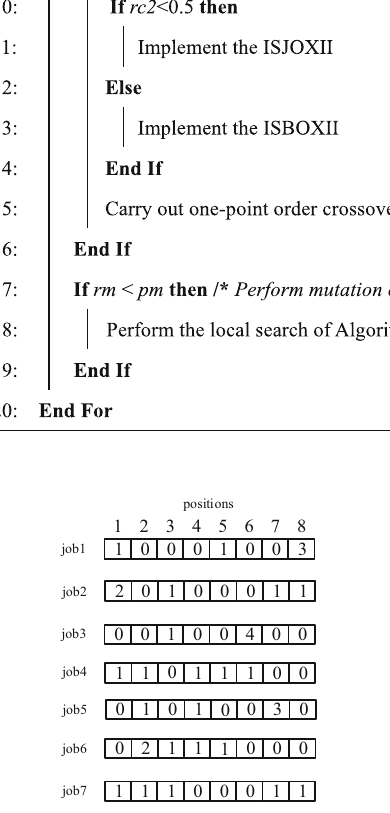
Fig. 8 Process of generating a temporary individual